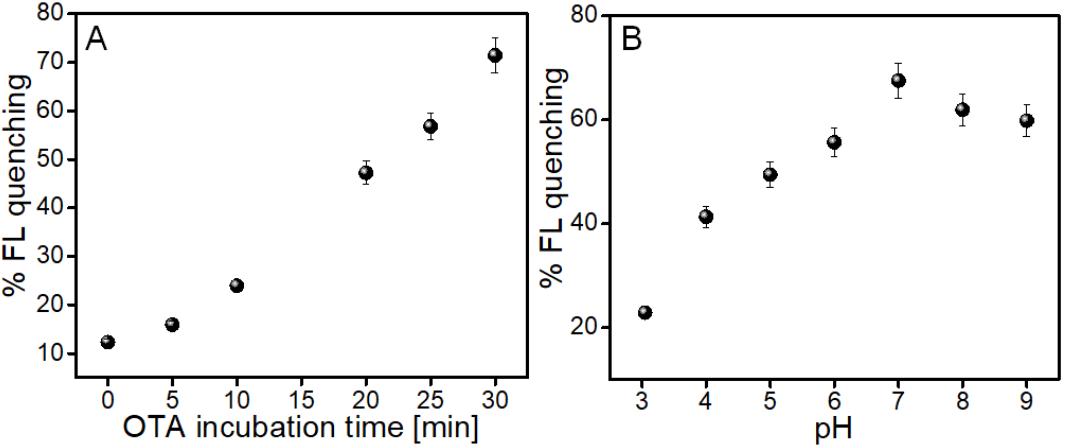
Figure 8. Effect of incubation time (0 – 30 min) of OTA (200 ng/L) ( A ) and pH (3 – 9) on % Fl quenching ( B ).